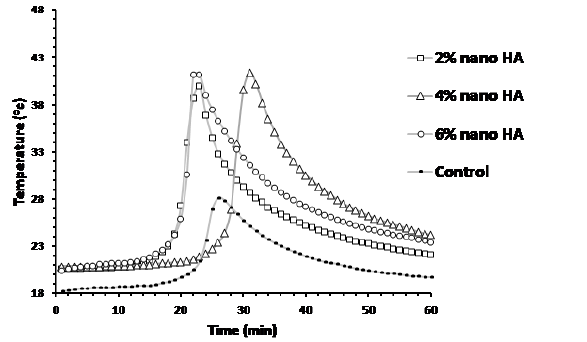
Figure 2. Representative polymerization temperature measurements for PMMA/nano-HA compositions as a function of time after start of mixing